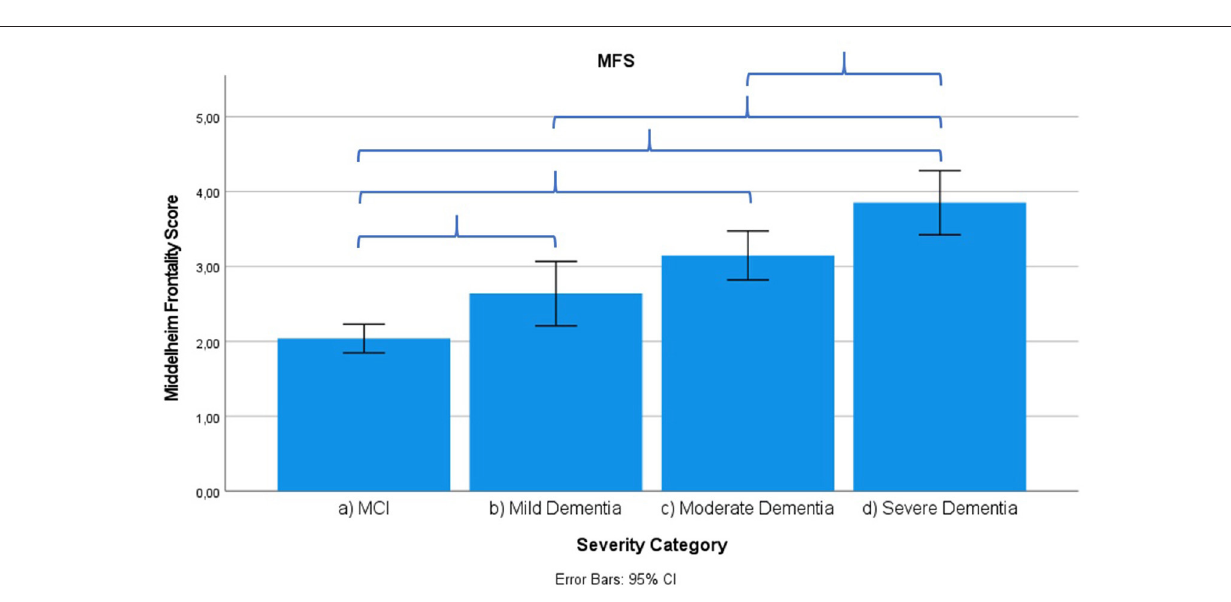
Frontiers in Psychiatry |